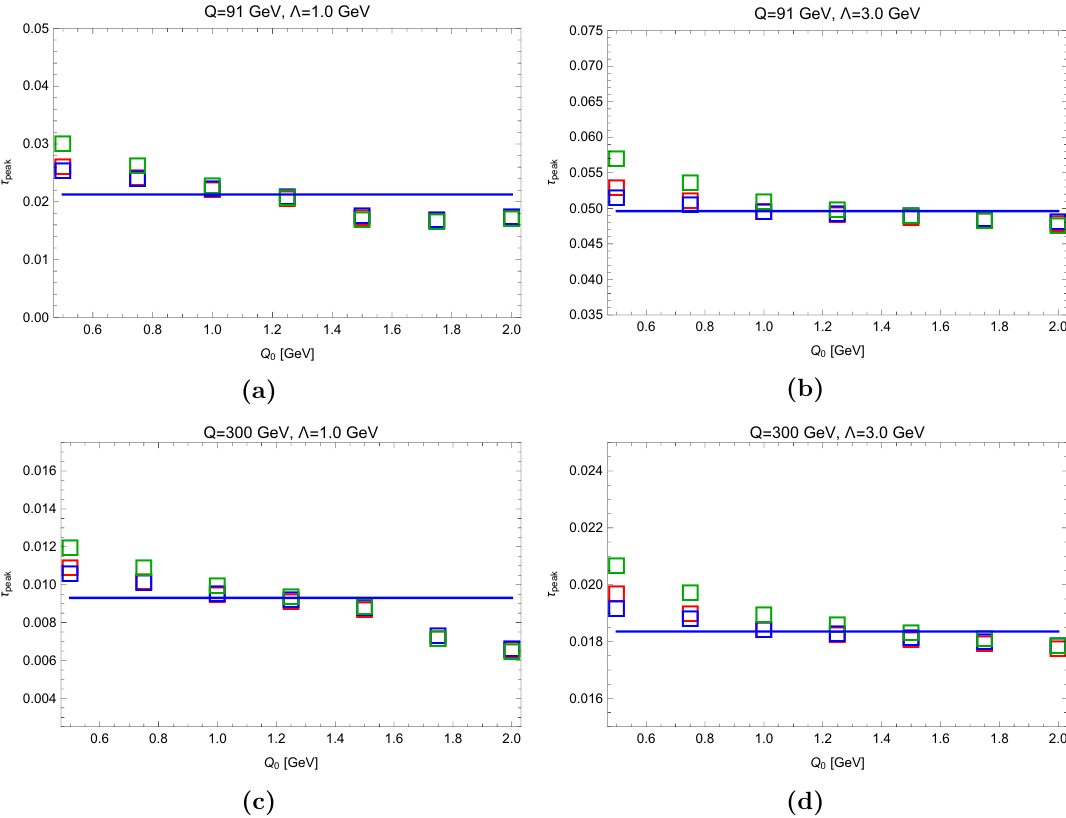
Figure 11. Peak position (cid:28) peak at the parton level obtained from Herwig 7 for the parameters used in (cid:12)gure 10, but including the soft function gap calculated analytically to achieve results that eliminate the linear dependence on the shower cut Q 0 taking Q 0 blue solid line represents the corresponding analytic